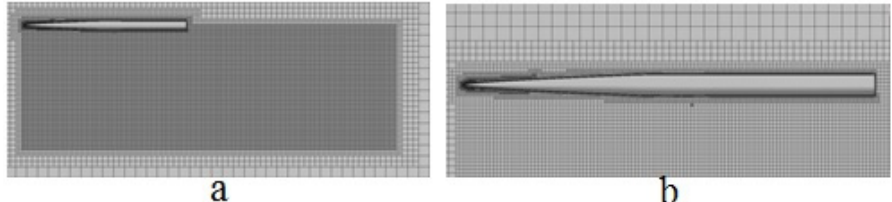
Figure 10. Computational domain. ( a ) general view, ( b ) closeup.